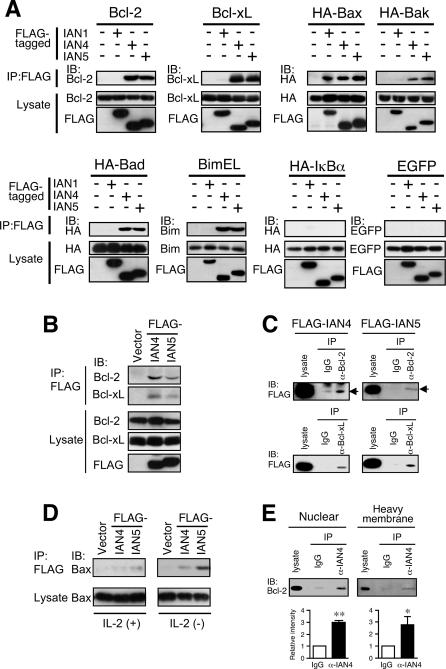
Interaction of IAN Family Proteins with Bcl-2 Family Proteins(A) 293T cells were co-transfected with FLAG-tagged IAN molecules together with Bcl-2, Bcl-xL, HA-tagged Bax, HA-tagged Bak, HA-tagged Bad, BimEL, HA-tagged IκBα, or EGFP. Cell lysates were IP with anti-FLAG M2 antibody and IB with indicated antibodies.(B) 23–1–8 T cells expressing EGFP alone (Vector), FLAG-tagged IAN4, or FLAG-tagged IAN5 were IP with anti-FLAG M2 antibody and IB with anti-Bcl-2 or anti-Bcl-xL antibody.(C) 23–1–8 T cells expressing FLAG-tagged IAN4 or FLAG-tagged IAN5 were IP with normal IgG or anti-Bcl-2 or anti-Bcl-xL antibody and IB with anti-FLAG M2 antibody. Arrows indicate FLAG-tagged IAN4 or FLAG-tagged IAN5.(D) 23–1–8 T cells expressing EGFP alone (Vector), FLAG-tagged IAN4, or FLAG-tagged IAN5 were cultured in the presence or absence of IL-2 for 36 h. Cell lysates were IP with anti-FLAG M2 antibody and IB with anti-Bax antibody.(E) Nuclear and heavy membrane fractions prepared from 23–1–8 T cells were lysed in buffer containing 1% CHAPS. The lysates were IP with normal rabbit IgG or anti-IAN4 antibody and IB with anti-Bcl-2 antibody. Means and standard errors (
n = 4) of relative intensities of the bands were analyzed by using NIH Image software.

*
p < 0.05;
**
p < 0.01.